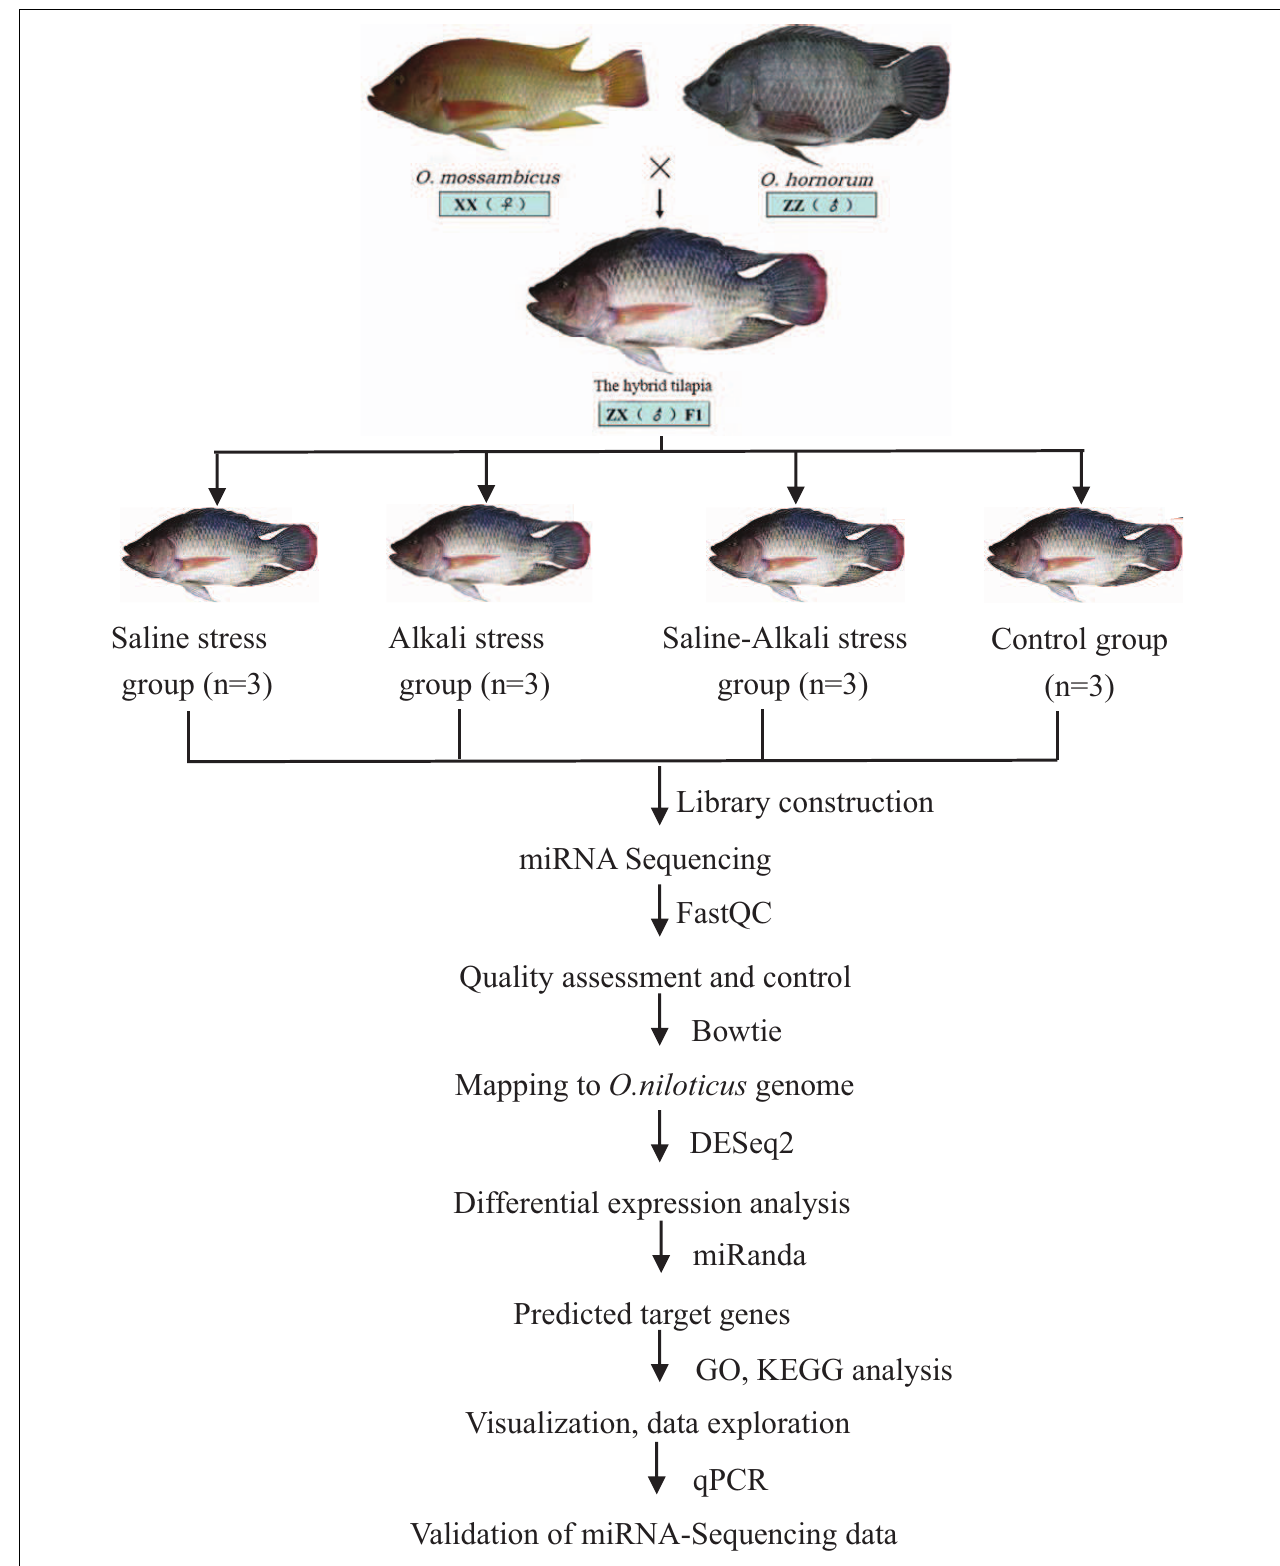
FIGURE 1 | Overview of the experimental design. Flowchart represents miRNA-Seq workflow and bioinformatics analysis workflow.